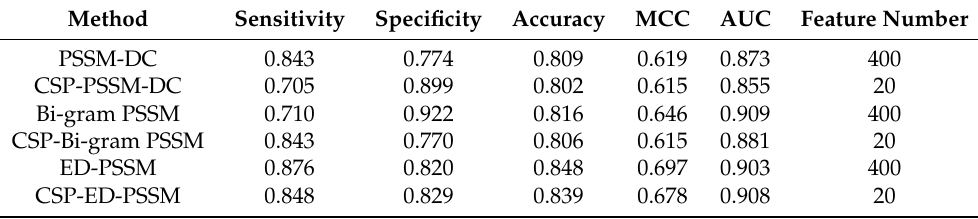
Table 2. Prediction results of the CSP based feature extraction method and traditional feature extraction methods from evolutionary information.